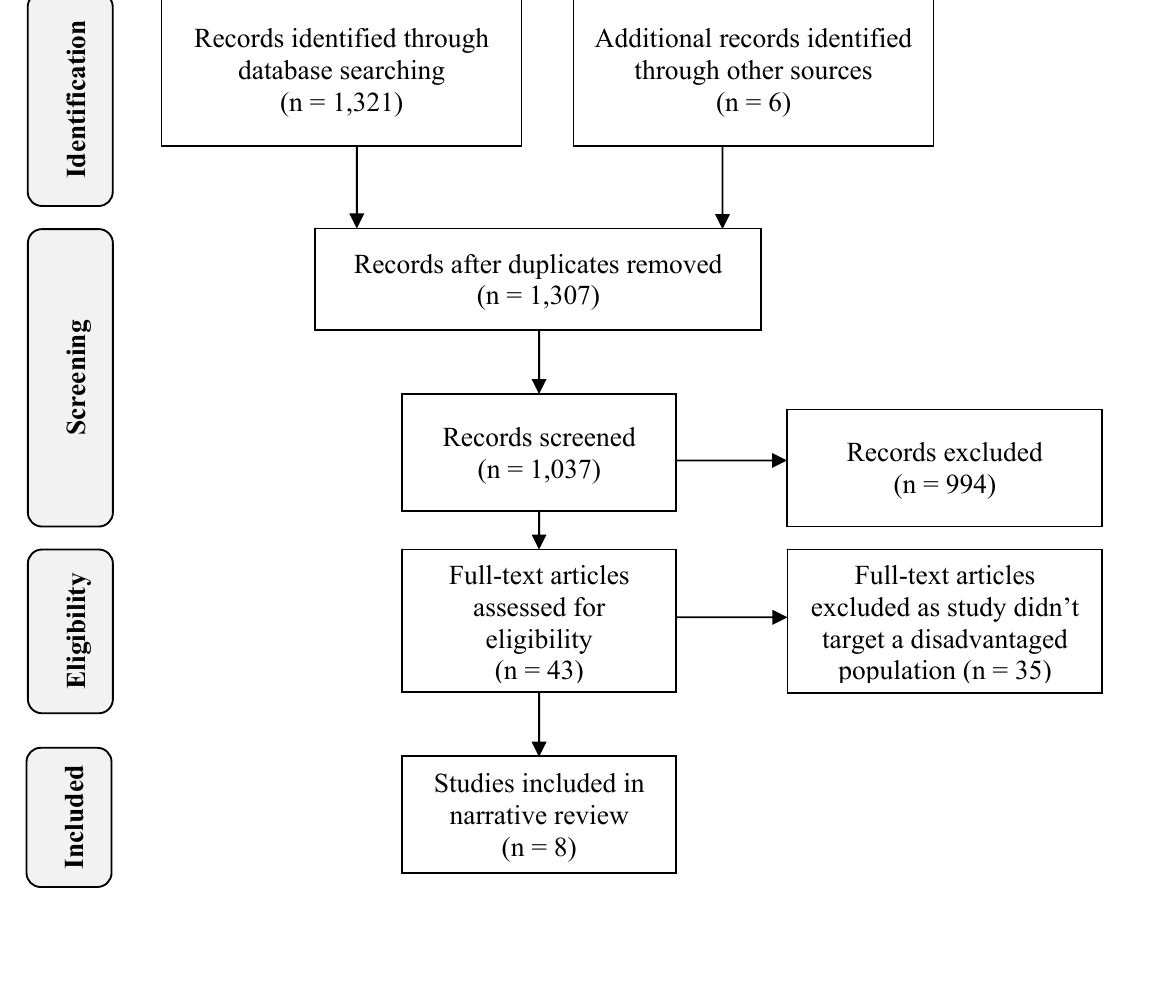
Figure 1. Flow diagram of selection of studies for the systematic review (adapted from